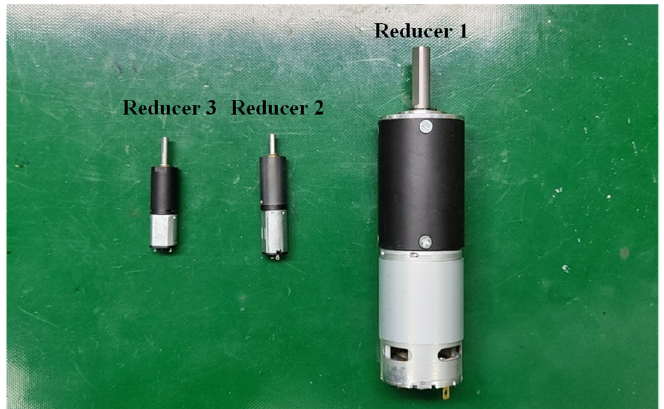
Figure 7. Appearance of three reducers.